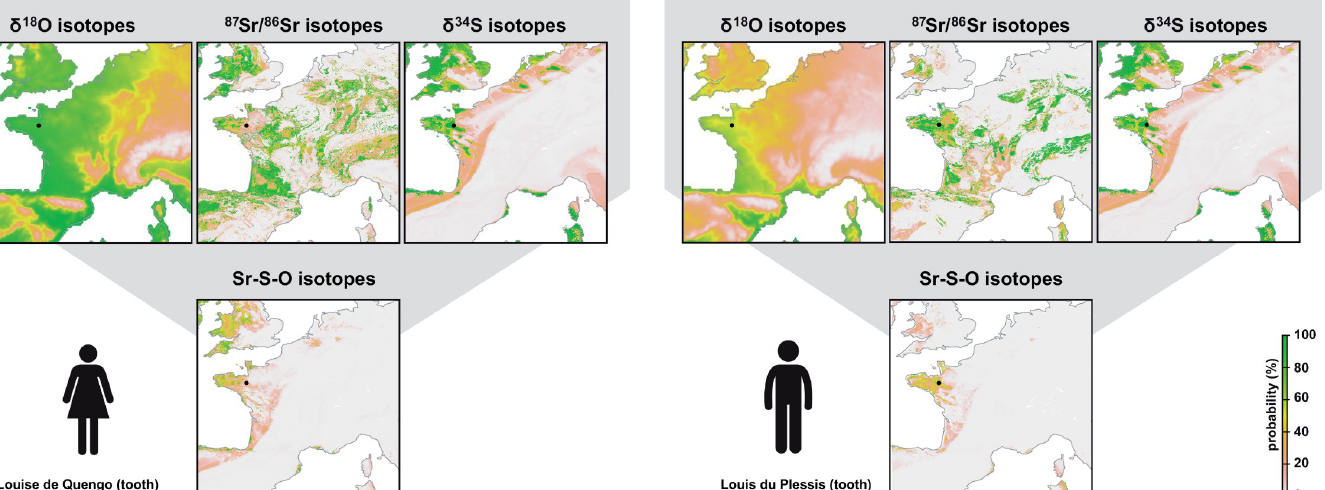
PLOS ONE | https://doi.org/10.1371/journal.pone.0250383 May 5,